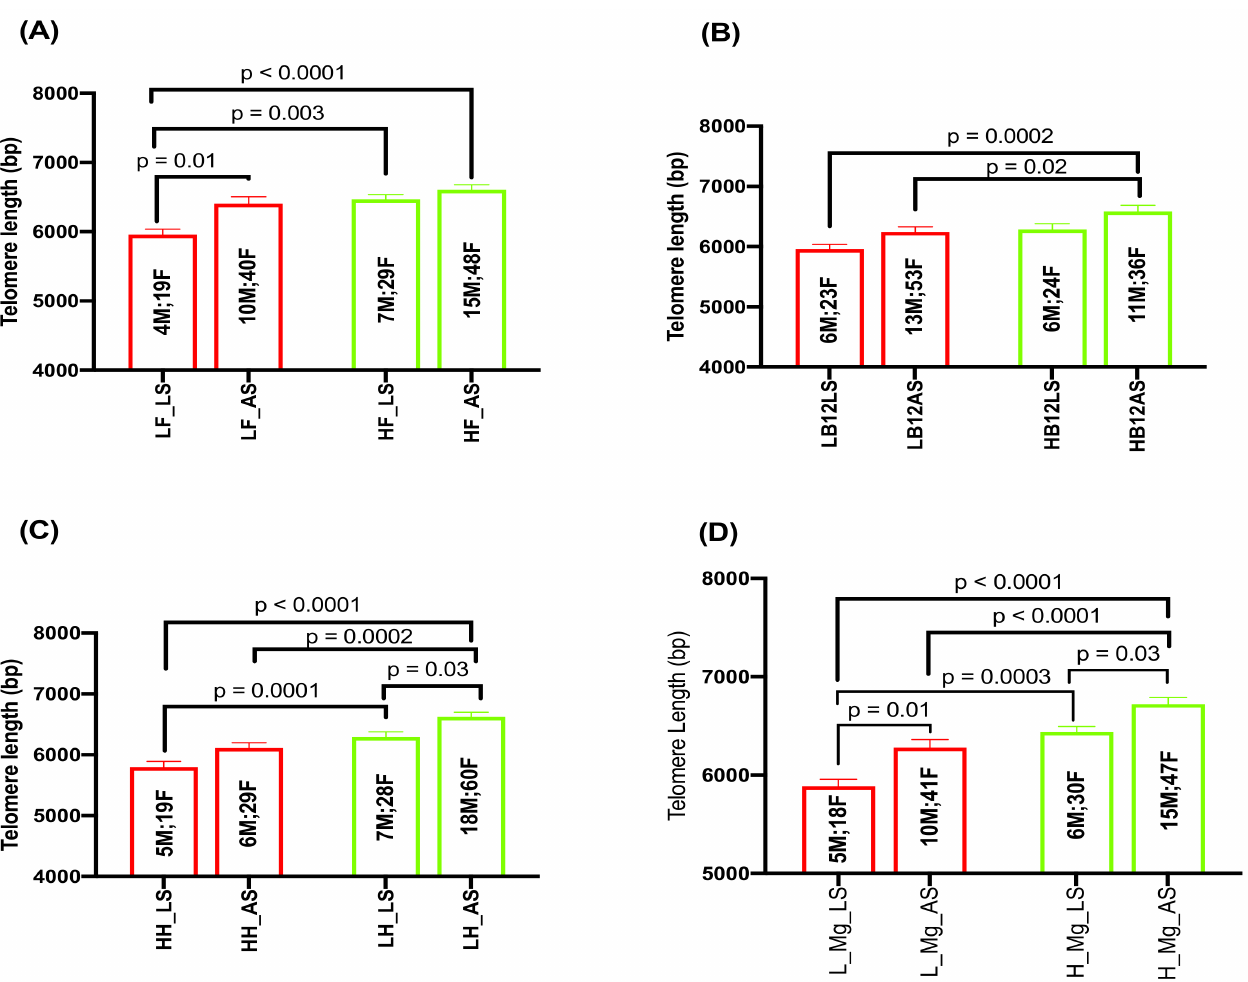
Figure 4. ( A ) Association of sleep duration (LS: <7 h; AS: ≥ 7 h) with telomere length in subjects with low folate (LF) and high folate (HF); ( B ) association of sleep duration with TL in subjects with low B 12 (LB12) and high B 12 (HB12); ( C ) association of sleep duration with TL in subjects with low homocysteine (LH) and high homocysteine (HH) and ( D ) association of sleep duration with TL in subjects with low magnesium (L Mg) and high magnesium (H Mg). Number of subjects in each category (male and female) is shown in the middle of each